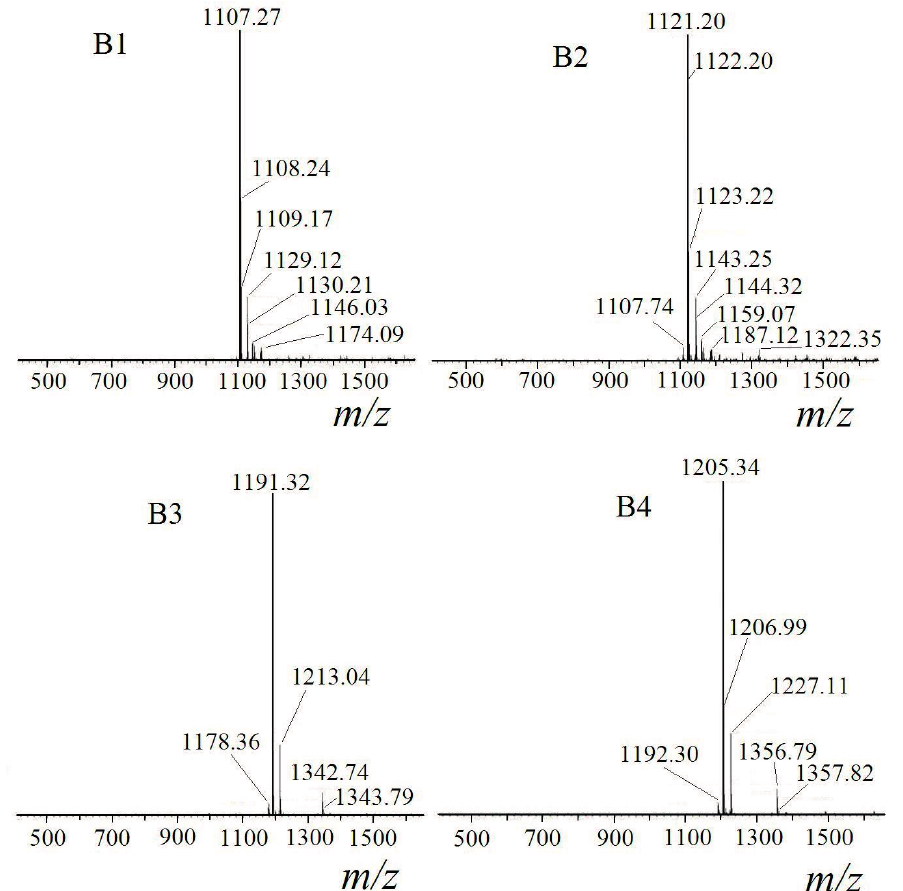
Figure 4. Electrospray ionization mass spectrometry (ESI-MS) spectroscopy of B1–B4.